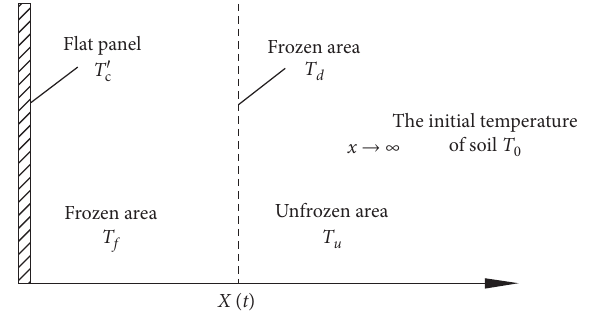
Figure 7: Plate freezing